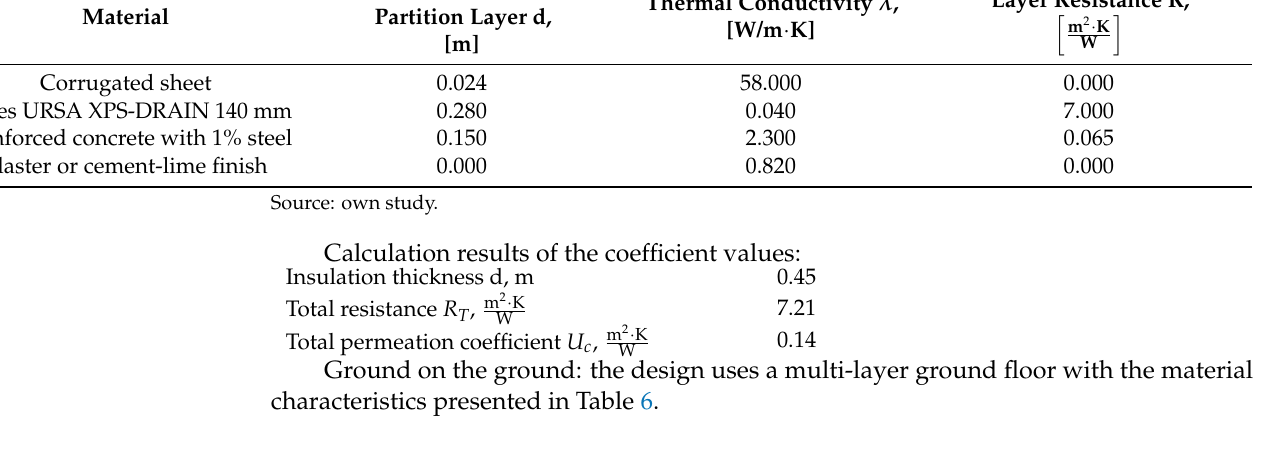
Table 6. Characteristics of the partition-floor on the ground. Material